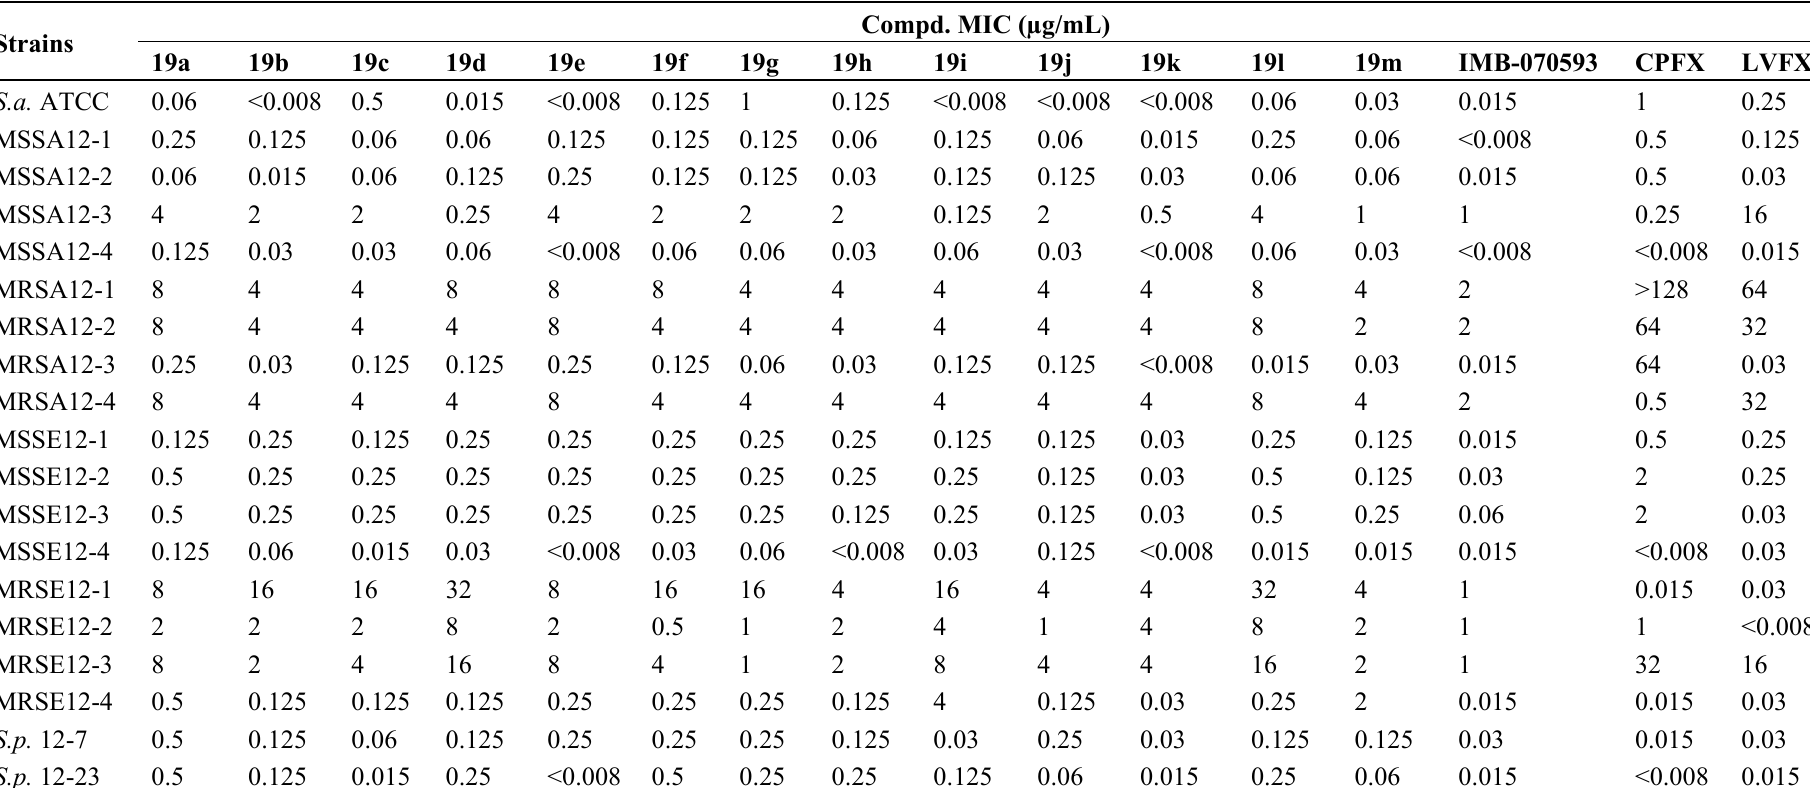
Table 2. In vitro antibacterial activity of compounds 19a – m against Gram-positive